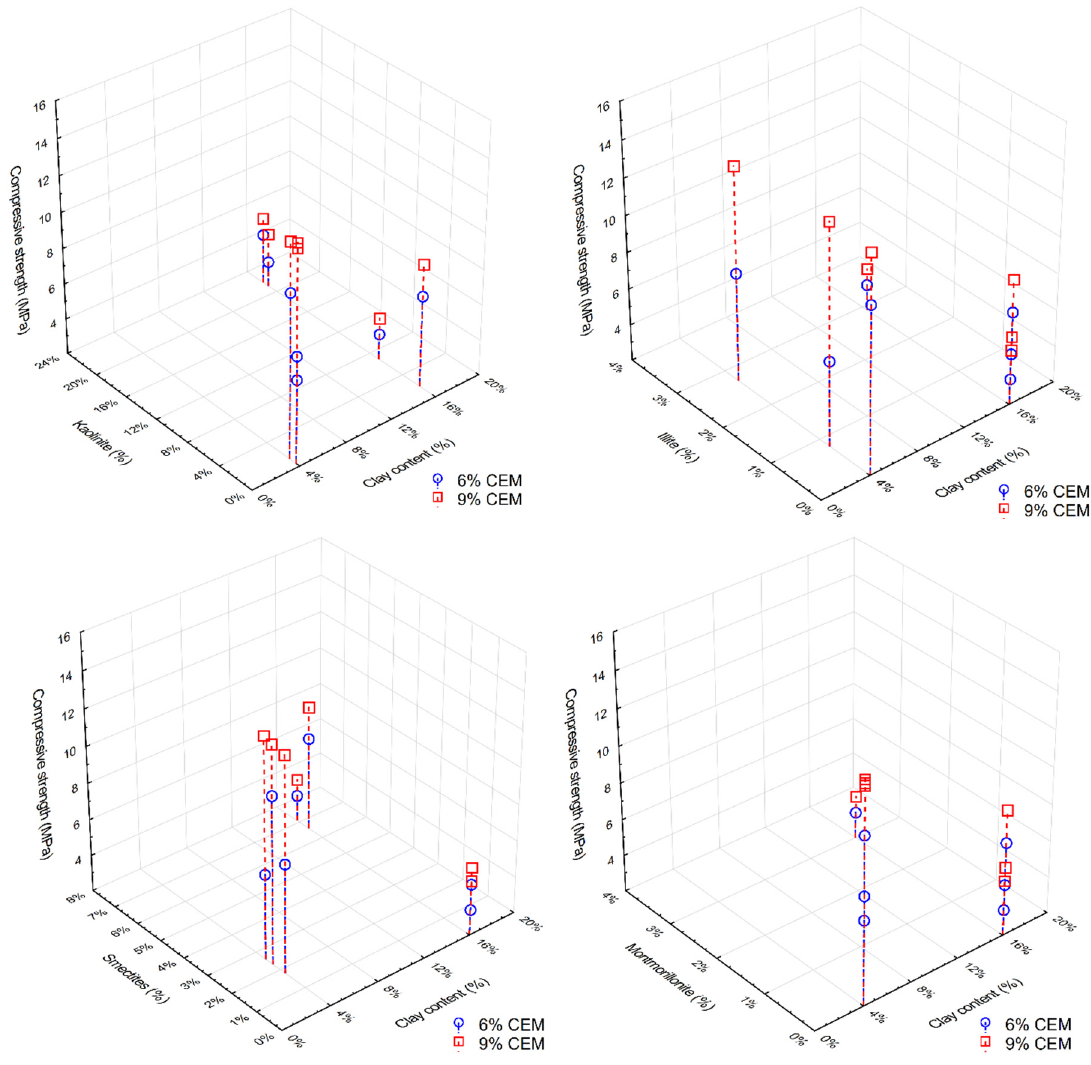
Figure 10. Compressive strength in comparison to the clay fraction content and the amount of each clay mineral: kaolinite (top left), illite (top right), smectites (bottom left), and montmorillonite (bottom right).